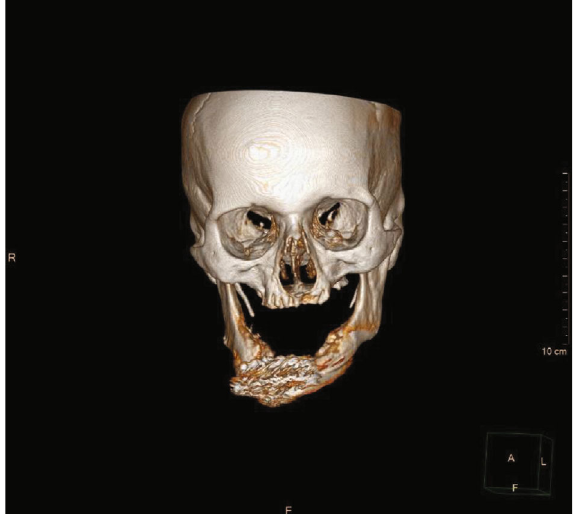
Figure 7: Plates in situ 9 ( fi rst surgery).